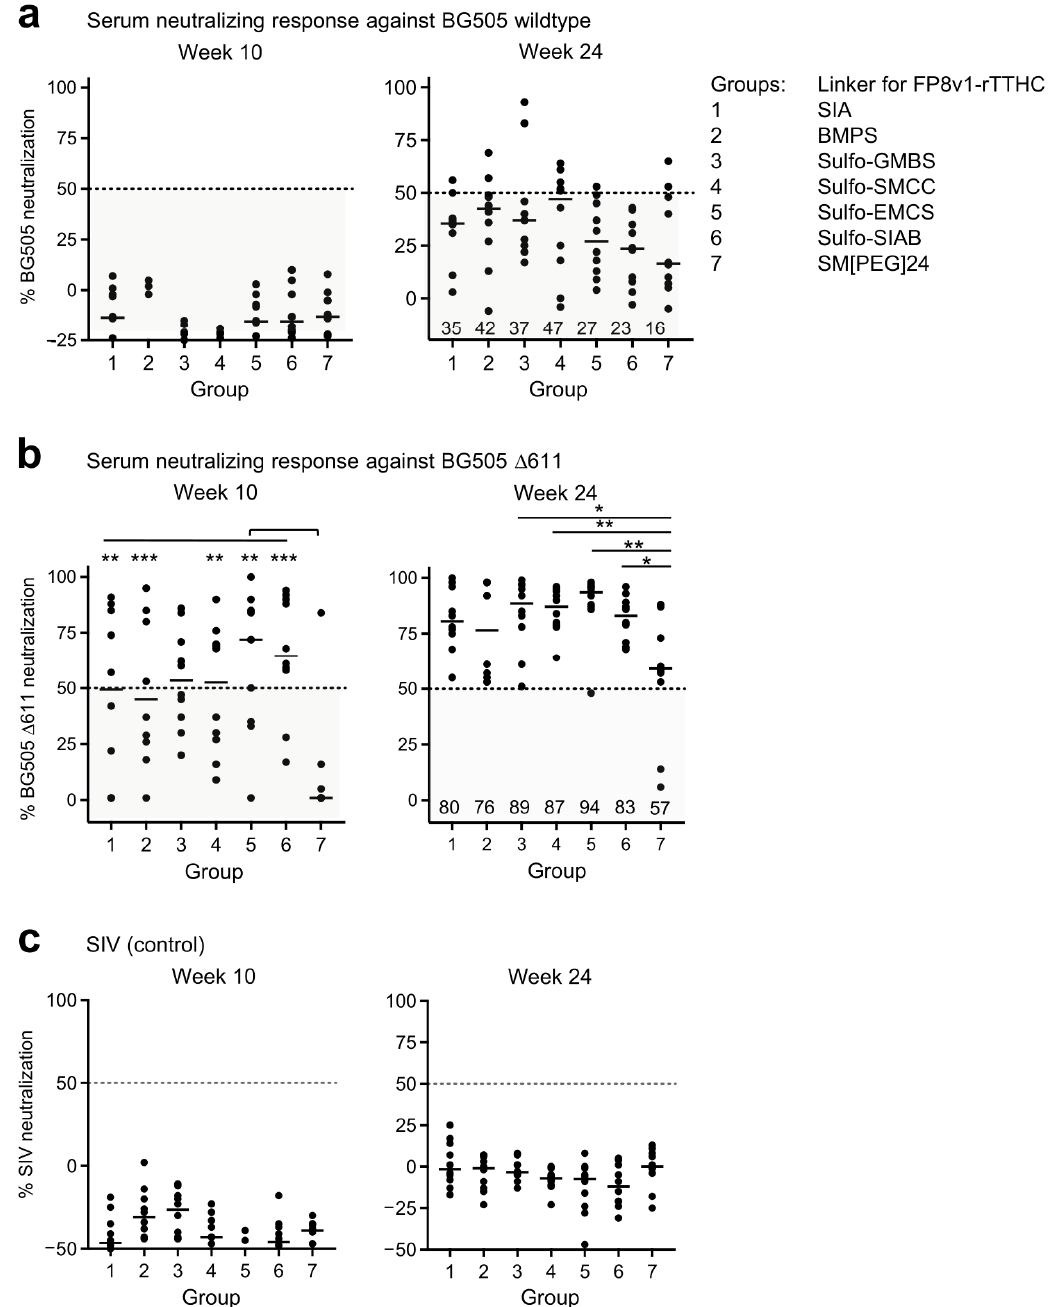
Figure 4. Several linkers for FP8v1-rTTHC yield similar neutralization responses. Virus neutralization assays with the immune sera at week 24 and 10 against ( a ) wildtype BG505, ( b ) BG505 Δ 611 virus and ( c ) control SIV. Virus neutralization assays with the immune sera at 1:50 dilution. p values were calculated with Mann–Whitney two-tailed t test: * p < 0.05; ** p < 0.01; *** p < 0.001. The values below than 50% are considered to be less potent and shaded in a semi-transparent gray box.